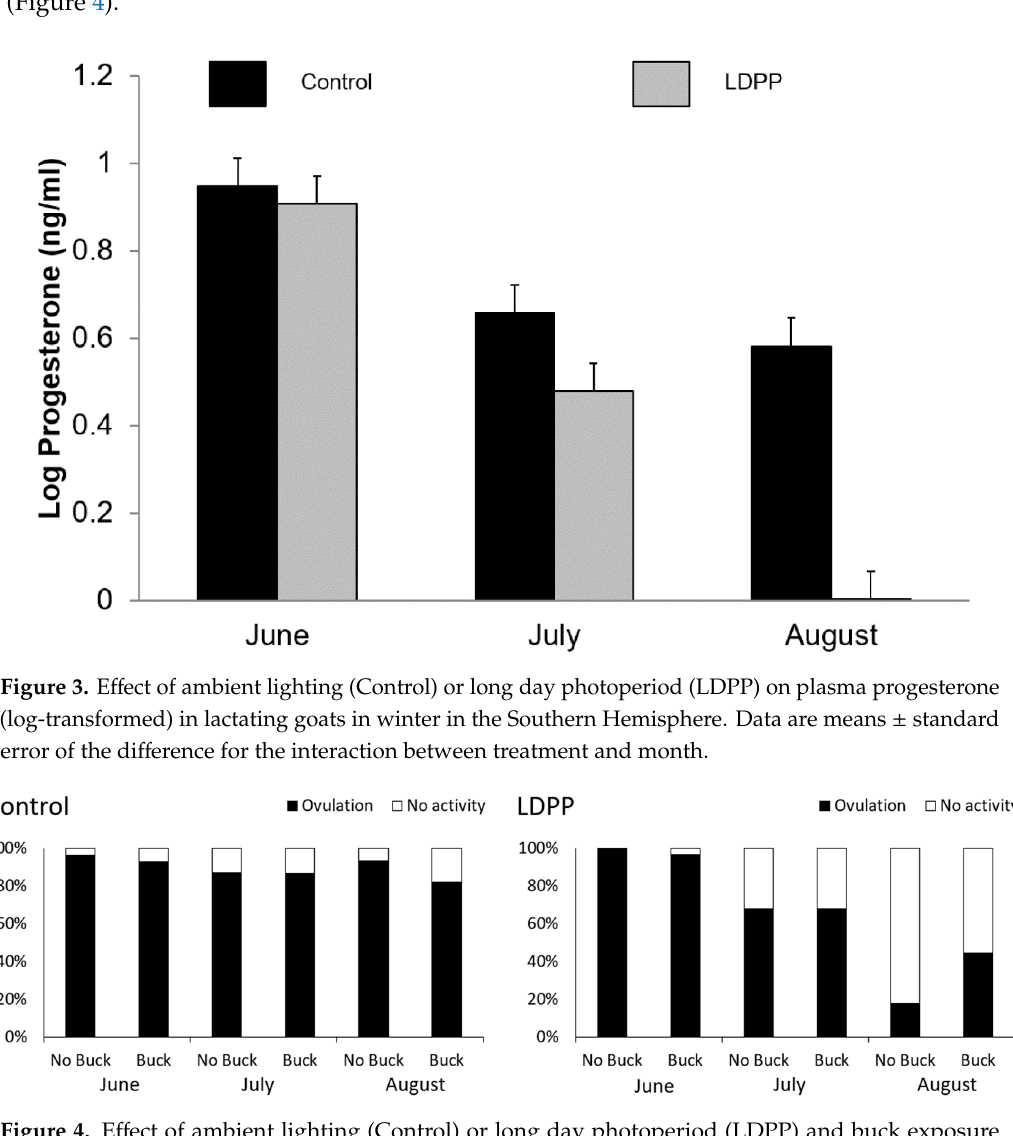
Figure 2. Effect of ambient lighting (Control) or long day photoperiod (LDPP) on plasma prolactin (log-transformed) in lactating goats in winter in the Southern Hemisphere. Data are means ± standard error of the difference for the interaction between treatment and month.